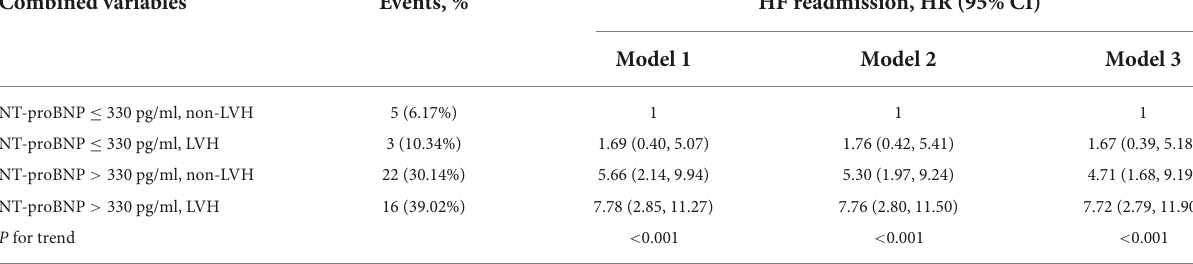
TABLE 4 Combined associations of NT-proBNP ( ≤ 330 pg/ml, > 330 pg/ml) and LVH on the incidence of HF